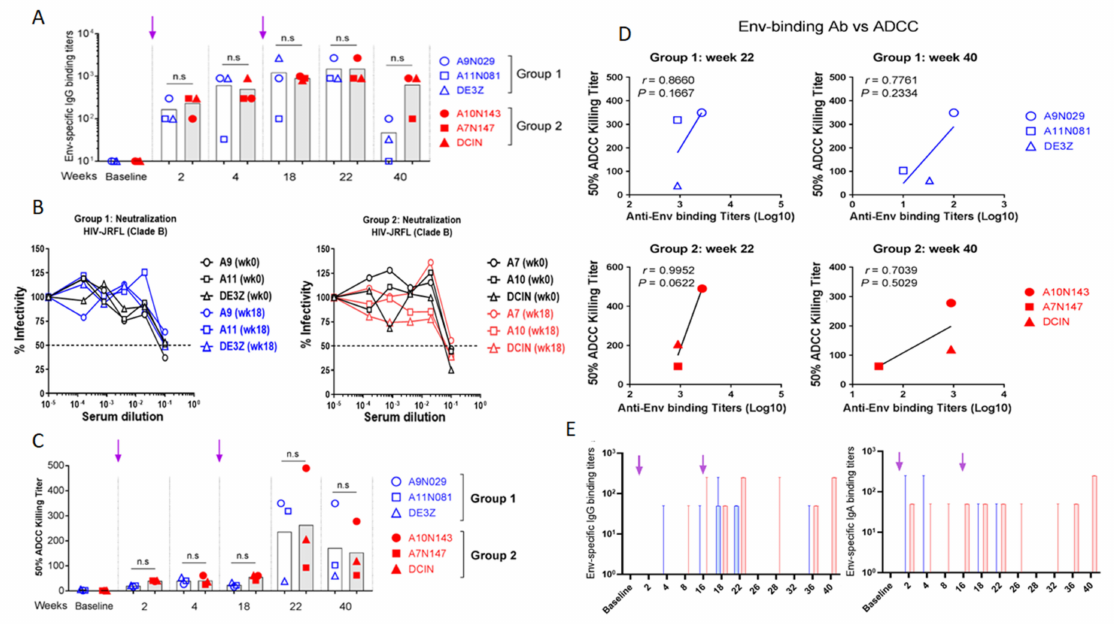
Figure 5. Vaccine-specific Abs in sera and mucosal secretions of vaccinated rhesus macaques. ( A ) Serum IgG samples harvested at indicated time points were evaluated by ELISA against in- activated HIV-1 JR-FL virus. Mean titers are plotted following subtraction of blank and baseline values. Arrows indicate immunization times. ( B ) Neutralizing activity of serum Abs was evaluated using the serum neutralization assay against Tier 2 HIV-1 JR-FL virus and TZM-bl indicator cells. IC 50 was determined by measuring the luminescence after 48 h incubation. ( C ) Evaluation of ADCC activity. Sera from both groups of vaccinated monkeys were incubated with HIV-1 JR-FL to inoculate CEM.NKr- CCR5 CD4 + target T cells. Effector KHYG-1 NK cells were added at a 10:1 effector-to-target ratio. After cell lysis, RLU was measured and ADCC activity evaluated for IC 50 . Mean values are reported. ( D ) Comparative evaluation of serum-binding and ADCC specific to Env epitopes in vaccinated macaques. Values were plotted to determine the correlate. ( E ) Evaluation of Env-specific Abs in rectal secretions. Rectal secretions were collected at indicated time points and analyzed by ELISA to detect both HIV-specific IgG and IgA against inactivated HIV-1 JR-FL . Cutoff was determined by subtracting the OD values of blank and baseline and median titers with 95% CI are shown. Group 1 (CAL-SHIV-IN − ) is represented in blue, and group 2 (CAL-SHIV-IN − IRES-rmIL-7 + CAL-SHIV-IN − IRES-rmIL-15) in red. ns: not significant. Arrows indicate immunization